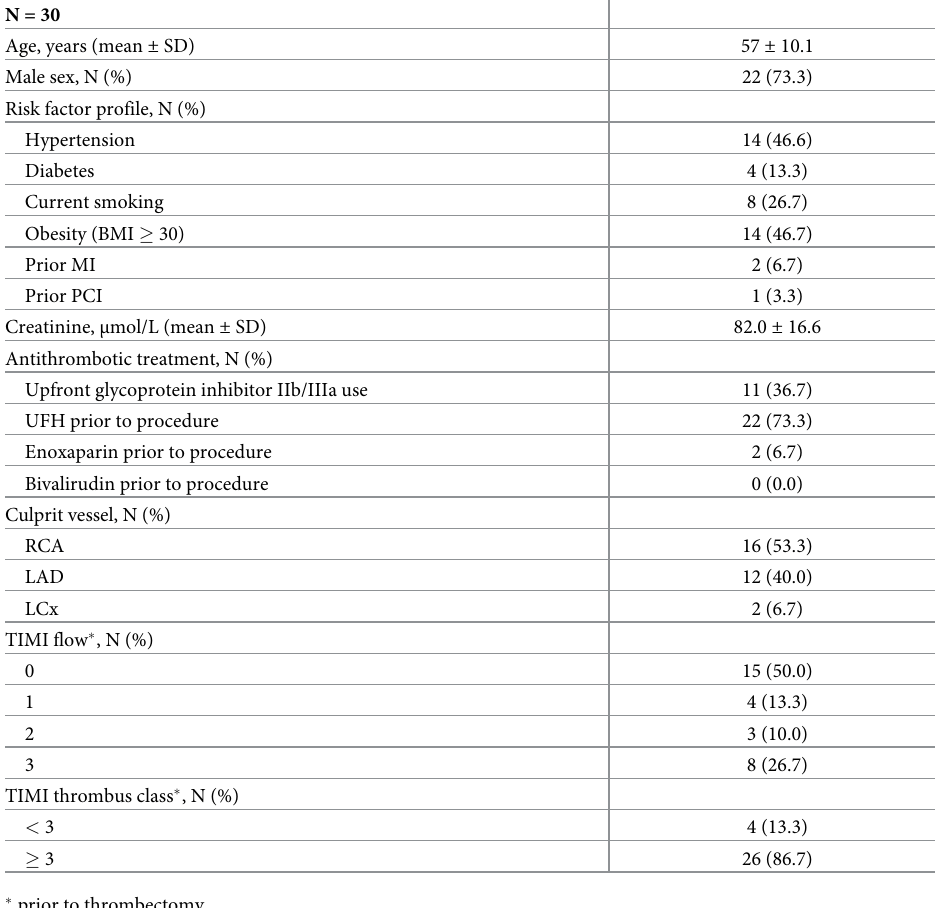
Table 1. Baseline patient